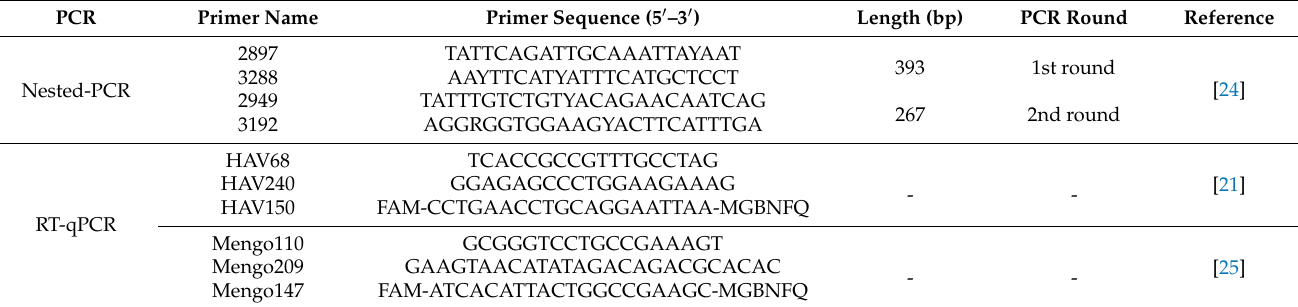
Table 1. RT-PCR and RT-qPCR primers and probes used in this study.